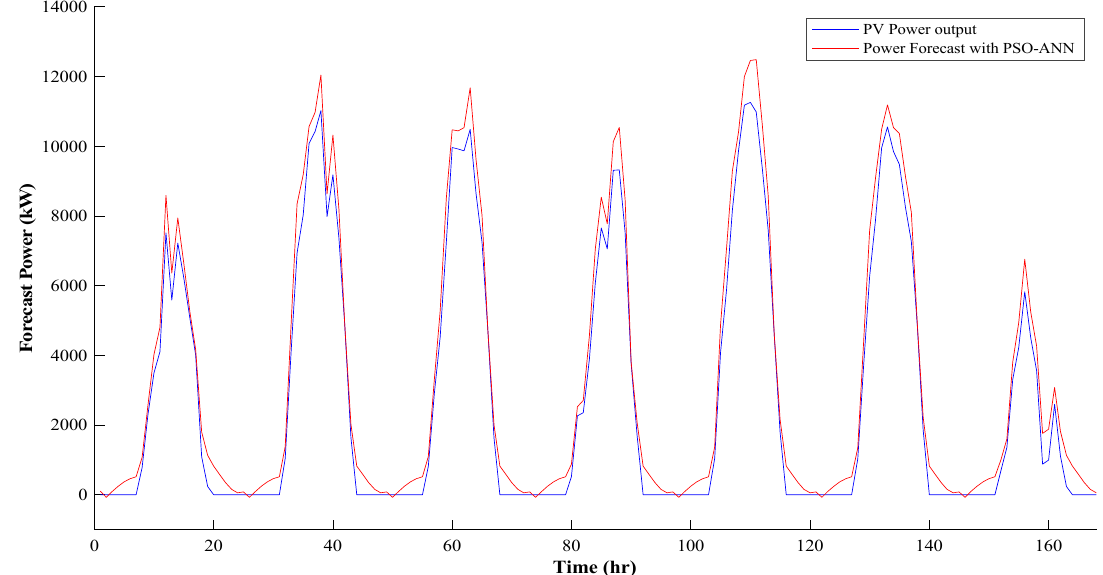
Figure 13. Weekly PV power output with PSO-ANN forecasting.